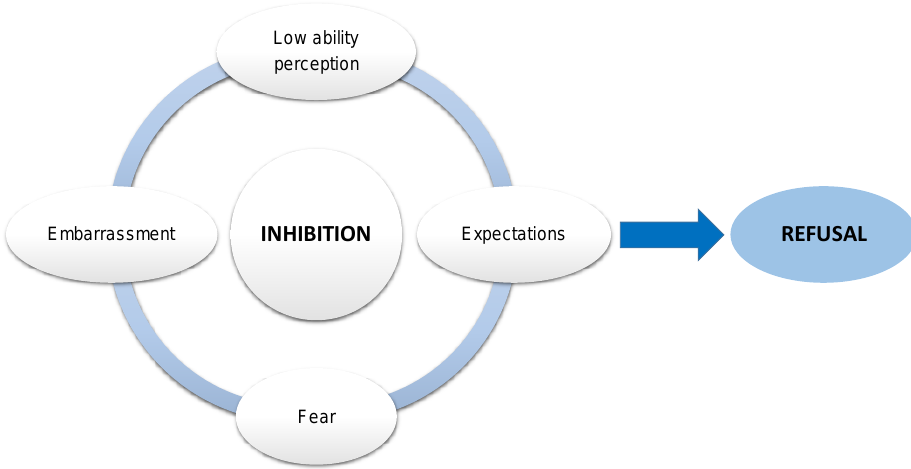
Figure 1. Proposed factor model that may explain students ’ initial behavior.